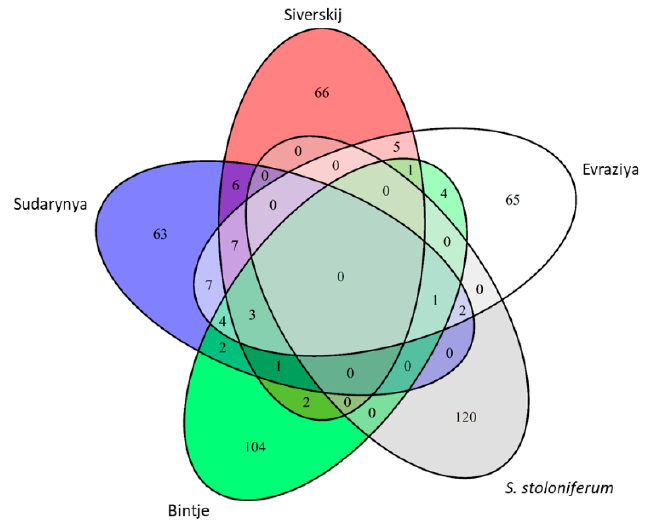
Figure 5. Intersection between the sets of new NLR proteins for cv. Siverskij (red), cv. Sudarynya (blue), cv. Evraziya (white), cv. Bintje (green), and S. stoloniferum clone 30514/15 (gray).